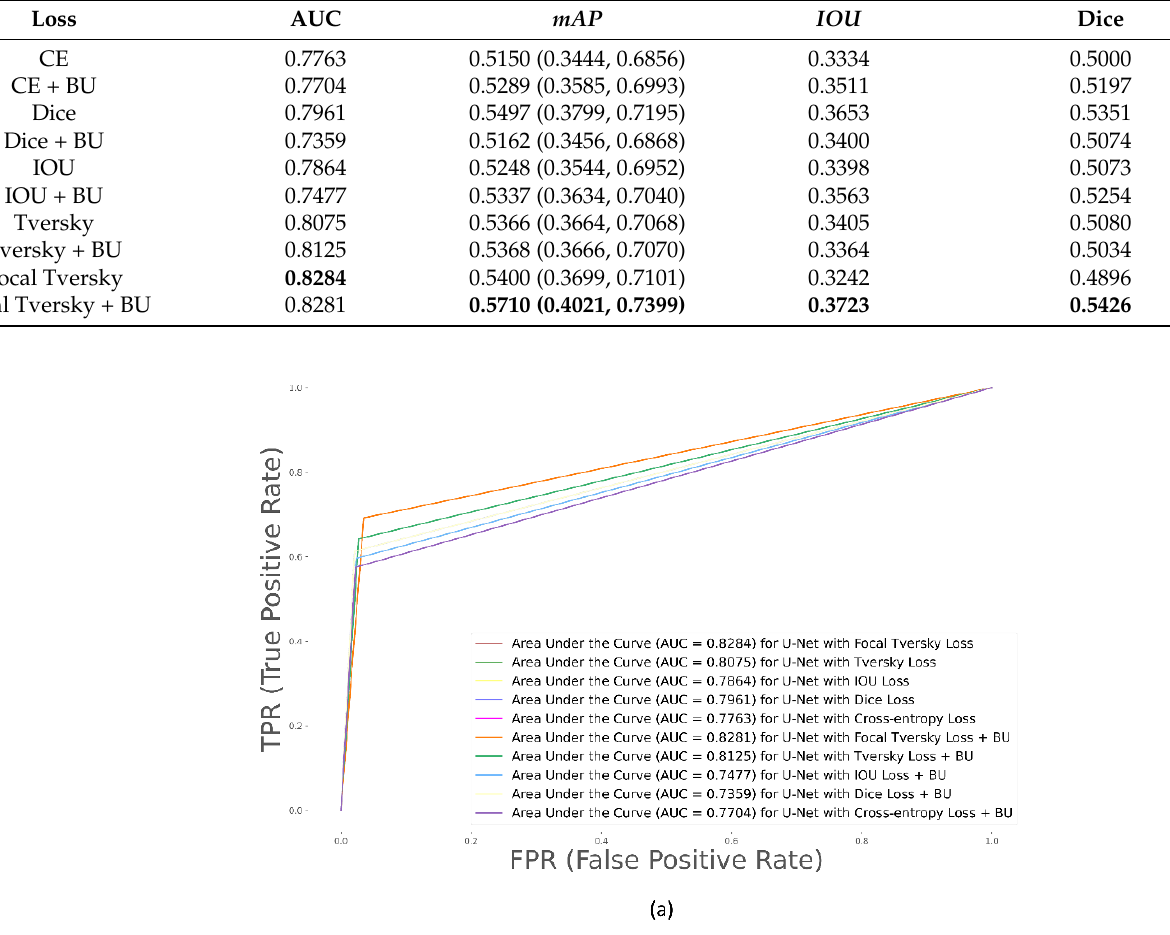
Figure 3. Test performance curves for the VGG ‐ 16 ‐ based U ‐ Net model trained with various loss functions. ( a ) ROC and ( b ) PR curves. The area under the PR curve (AUPRC) gives the mAP values. The AUC and AUPRC curves shown in brown color denote superior performance achieved by the models trained with Focal Tversky and Focal Tversky + BU losses, respectively. From Table 2, we observe that the VGG ‐ 16 ‐ based U ‐ Net trained with the Focal Tversky + BU loss demonstrated superior values in terms of mAP , IOU , and Dice metrics. The model trained with the Focal Tversky loss demonstrated superior values regarding the AUC metric. The 95% CI for the mAP metric achieved by the model trained with Focal Tversky + BU loss demonstrated a tighter error margin and hence higher precision and is observed to be significantly superior ( p < 0.05) to those achieved by the models trained with CE and Dice + BU losses. Since higher values of mAP denote that the model can better handle the positive (ROI) class and is more accurate in its detection, the model trained with the Focal Tversky + BU loss is chosen for further analysis. Figure 4 shows a sample CXR from the hold ‐ out test set, the ground ‐ truth ( GT ) mask, and the predictions of the models trained with the proposed loss functions. From Figure 4, we observe that predic ‐ tions from the model trained with the Focal Tversky + BU loss closely matched the GT , followed by Tversky, and Dice losses.